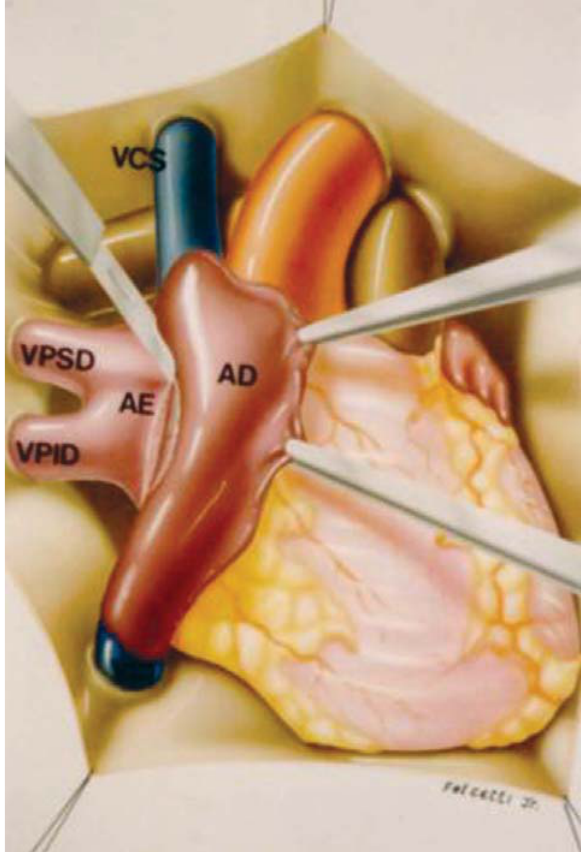
Fig. 1 - Abertura do sulco interatrial